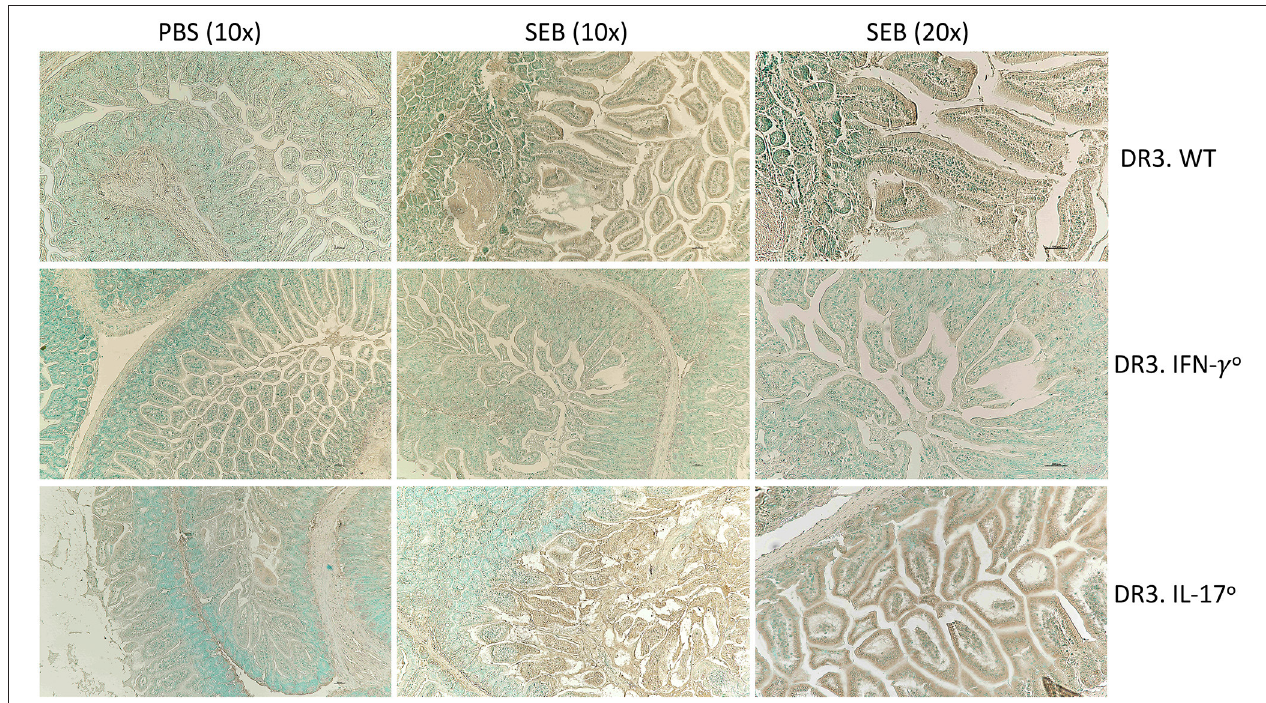
FIGURE 5 | IFN- γ and IL-17A deficiency differentially modulate apoptosis in small intestines in SAg-induced CRS. HLA-DR3.WT, DR3.IFN- γ ◦ , and DR3.IL-17 ◦ mice were challenged with 50 µ g of SEB in 200 µ l of PBS by intraperitoneal route. Groups of mice were euthanized at 24h, small intestinal tissues were embedded in paraffin, processed, and thin sections were made. Extent of apoptosis in intestinal tissues collected at 24h post SEB challenge was determined by TUNEL assay as described in methods. Representative images are shown.